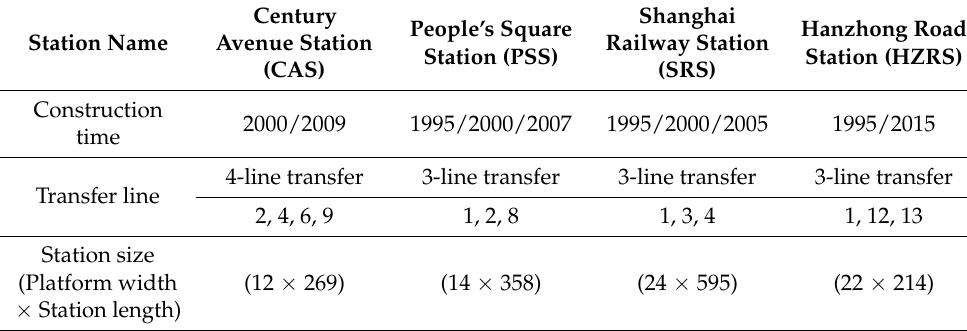
Figure 1. Spatial location map of research samples. Table 1. Overview of the research samples.